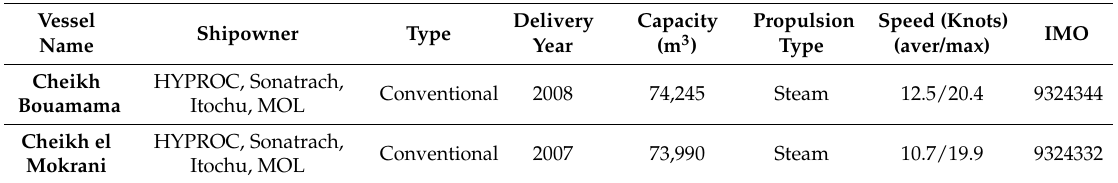
Table 8. Details for the used vessels.